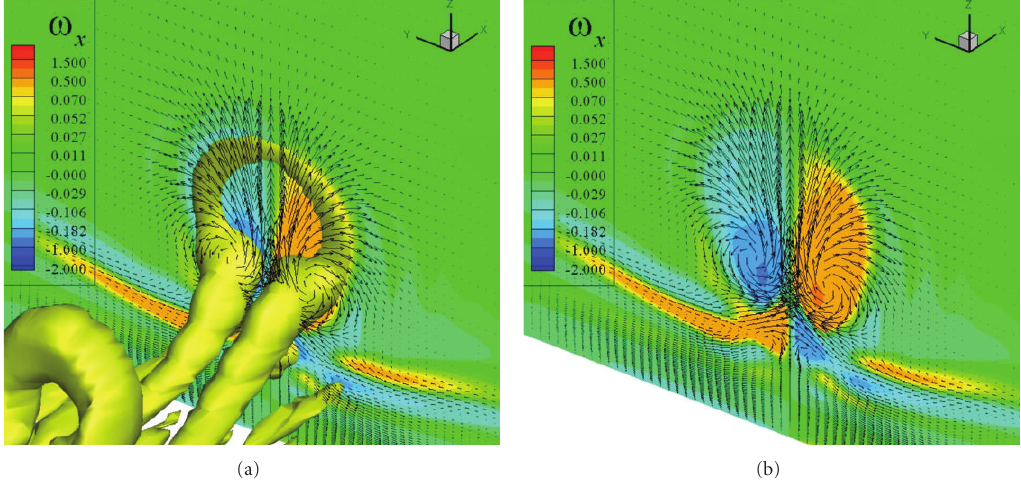
Figure 14: Formation processes of first ring-like